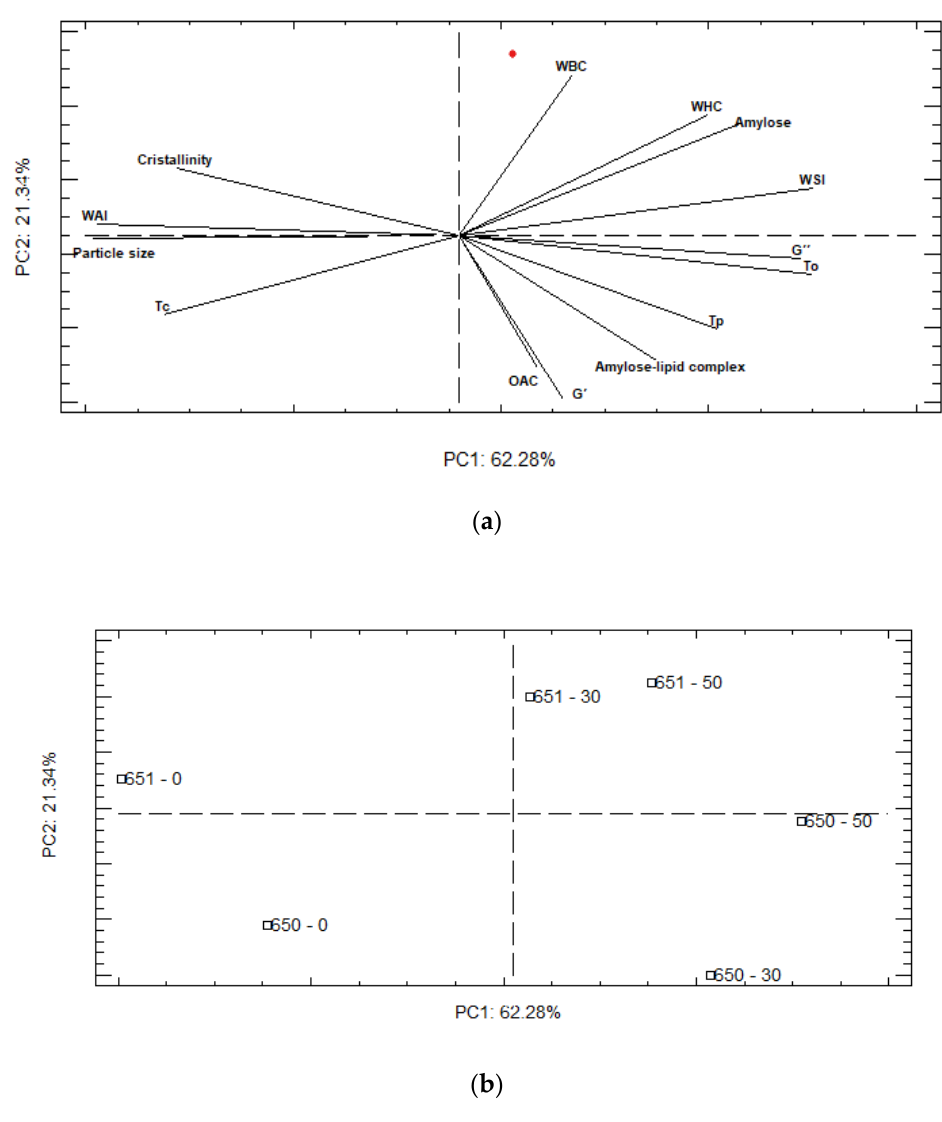
Figure 3. Dynamic frequency sweep moduli (G′, G″) and phase angle of different cassava starch varieties (INIAP 650, INIAP 651) and hydrolysis degree (0, 30, 50%).